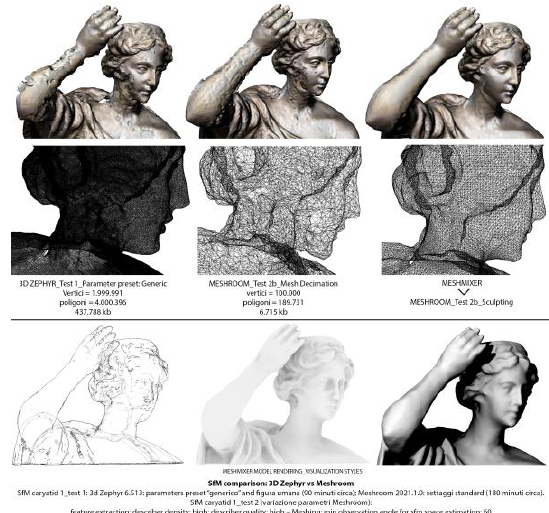
Figure 8 . SfM comparison: high-cost vs open-source tools